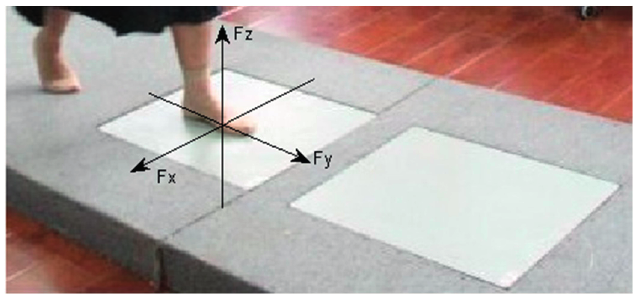
Figure 1. GRF components: F x F y , and F z on the multi-axis force platform. F x F y , and F z represent medial-lateral, anterior-posterior and superior-inferior GRF for foot during walking, respectively.